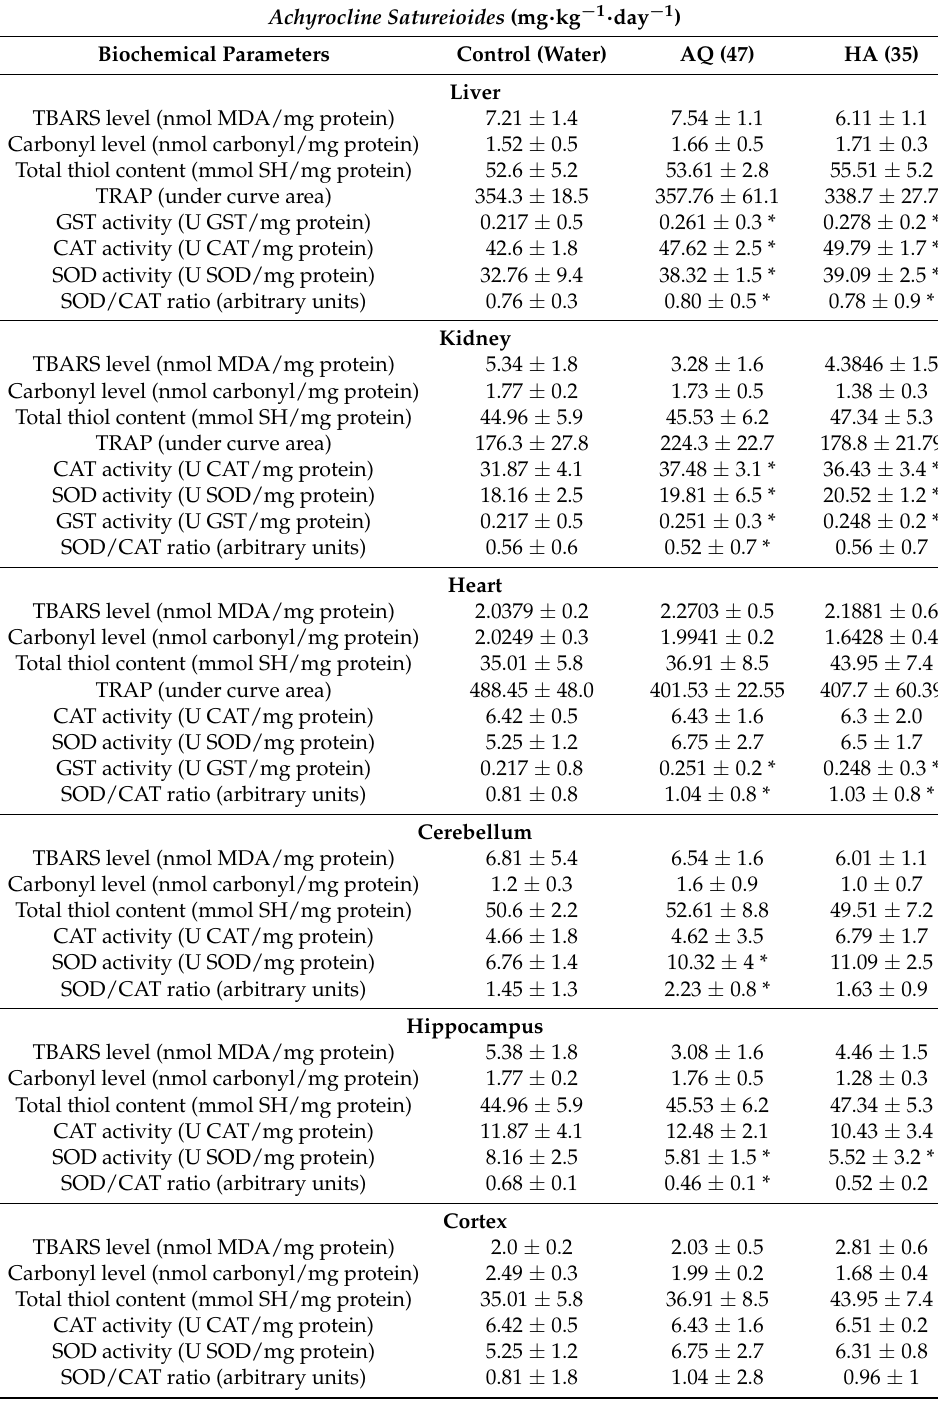
Table 3. Biochemical data of tissues from